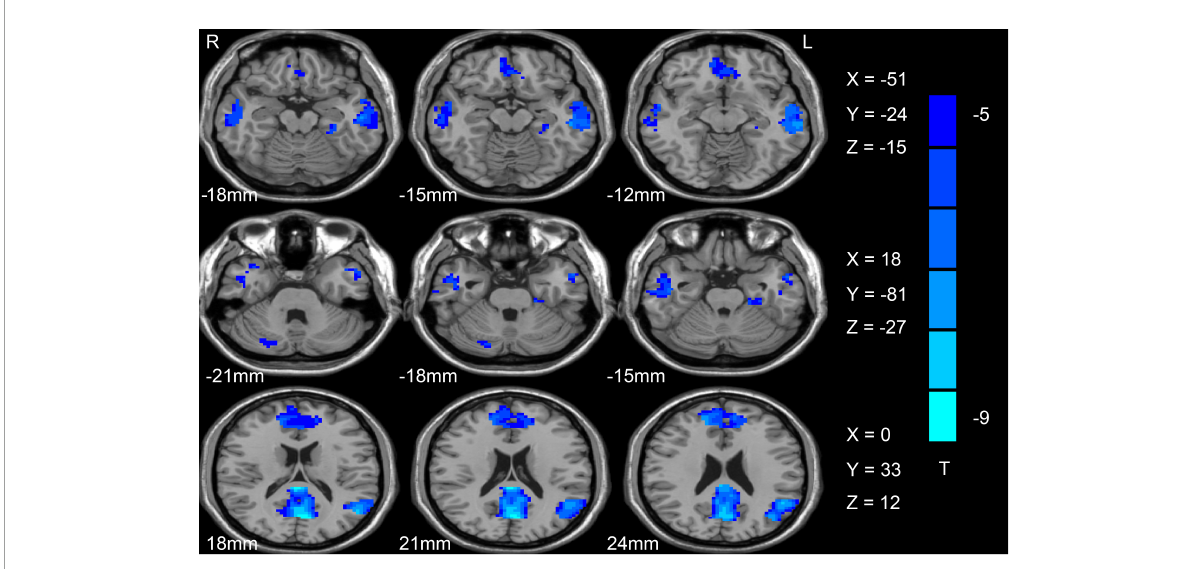
FIGURE1 Differences in ALFF values between SCH patients and HC individuals. Reduced ALFF values are shown in blue, with the color bar representing t -values in the group analysis. ALFF, amplitude of low-frequency fluctuation; SCH, schizophrenia; HCs, healthy controls.